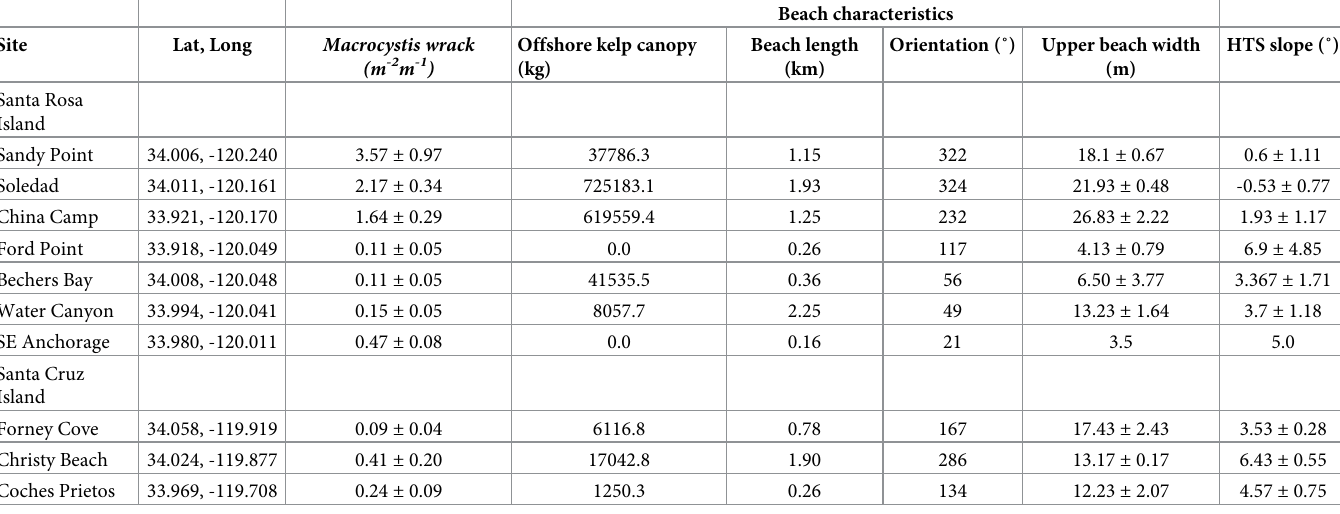
Table 1. Locations and values for physical and biological characteristics of sandy beach study sites on Santa Rosa and Santa Cruz Islands, California, USA.